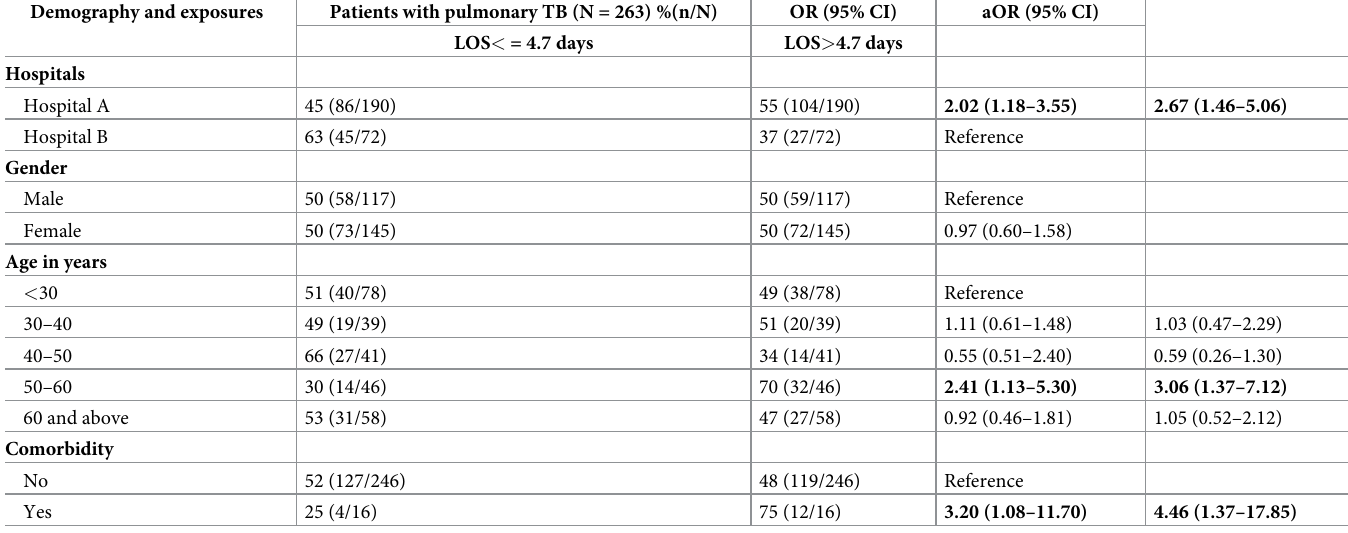
LOS-Length of hospital stay, OR-odds ratio, aOR-adjusted odds ratio, CI-confidence interval.